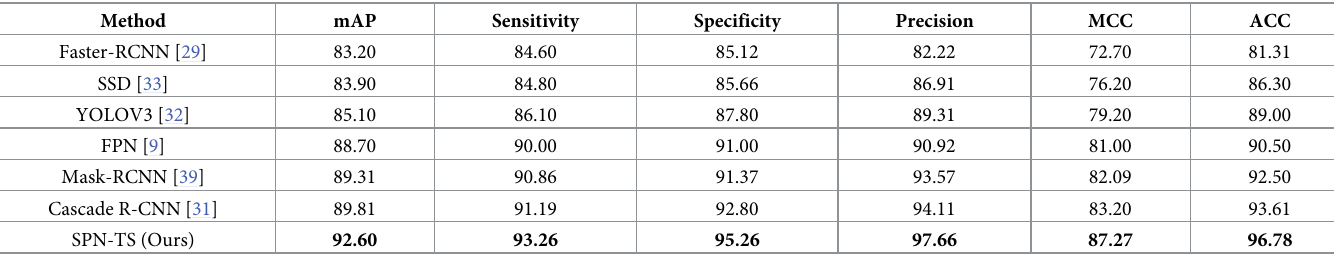
Table 1. Comparison of the method performance with existing general object detection.